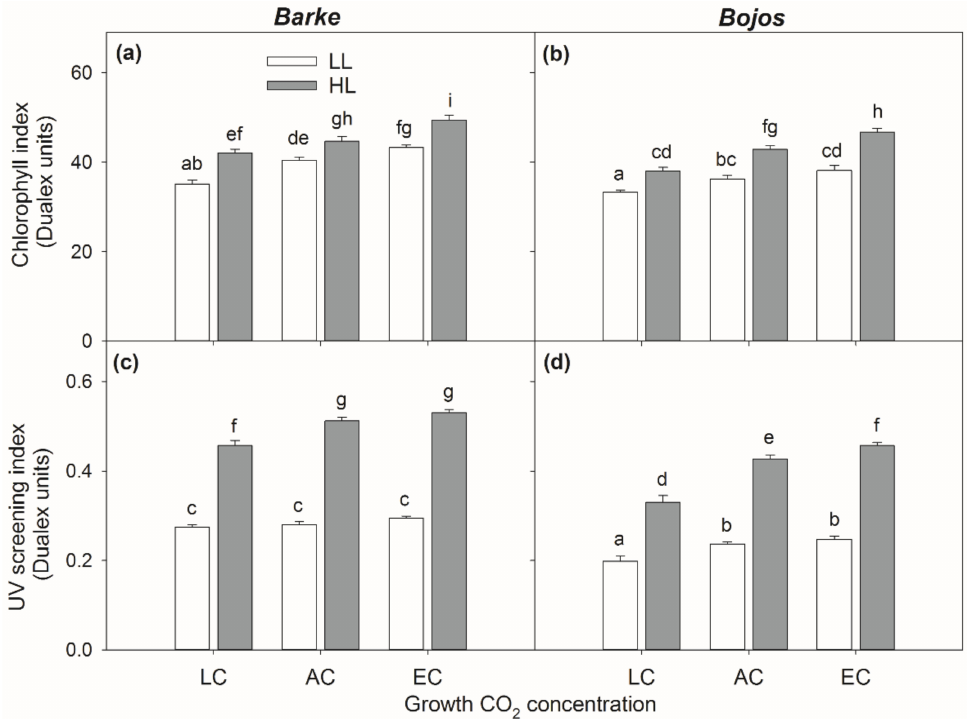
Figure 7. The effect of barley ( Hordeum vulgare) variety on chlorophyll index and UV screening index under different experimental treatments. ( a , c ) Barke, ( b , d ) Bojos, light intensity (white columns-low light (LL); grey columns–high light, (HL) and CO 2 concentration [CO 2 ]: low (LC), ambient (AC), elevated (EC) on chlorophyll index ( a , b ) and UV screening index ( c , d ) determined in vivo using instrument Dualex. The means (columns) and standard errors (error bars) are presented (n = 6). Different letters above columns indicate statistically significant differences between means tested by Fishers LSD post hoc test ( p = 0.05) across both